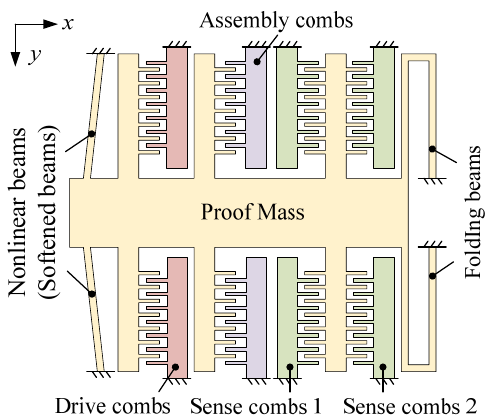
Figure 2. A schematic design of the sensor.